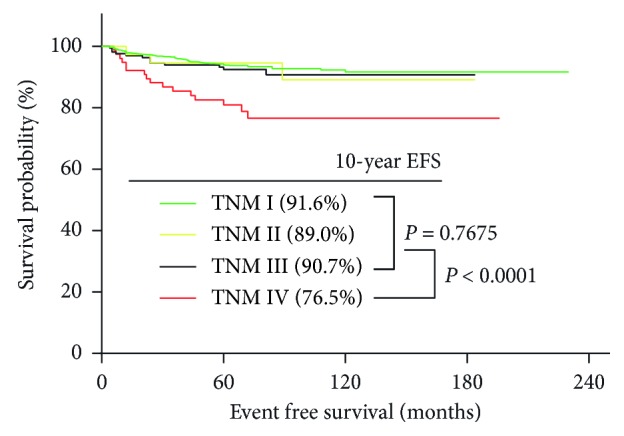
Kaplan–Meier survival curves for event-free survival (EFS) of PTC patients according to TNM stage in Zhejiang cohort. TNM staging in the figure was AJCC 7th edition based.